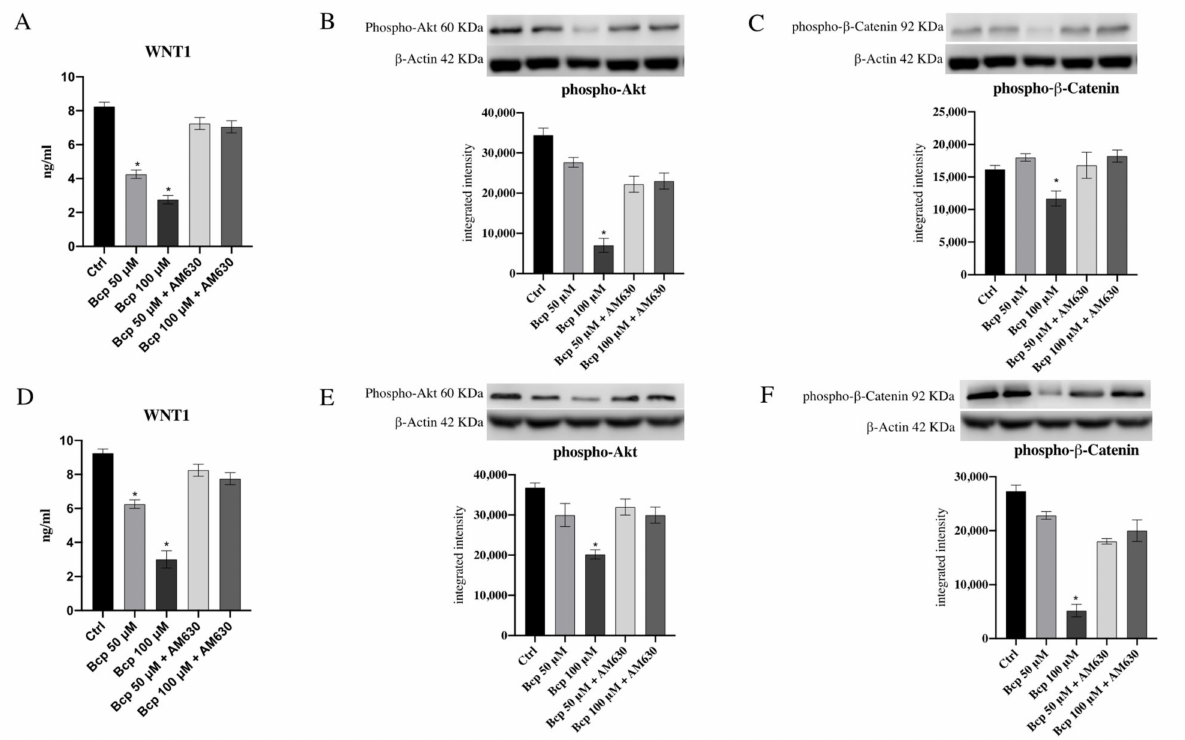
Figure 5. The graphs represent protein levels of Wnt1 ( A ), p-Akt ( B ), and p- β -Catenin ( C ) in MM.1S cells and Wnt1 ( D ), p-Akt ( E ), and p- β -Catenin ( F ) protein levels in MM.1R cells treated with BCP. The data are expressed as means ± SEM; n = 3 experiments; * p < 0.05 vs.